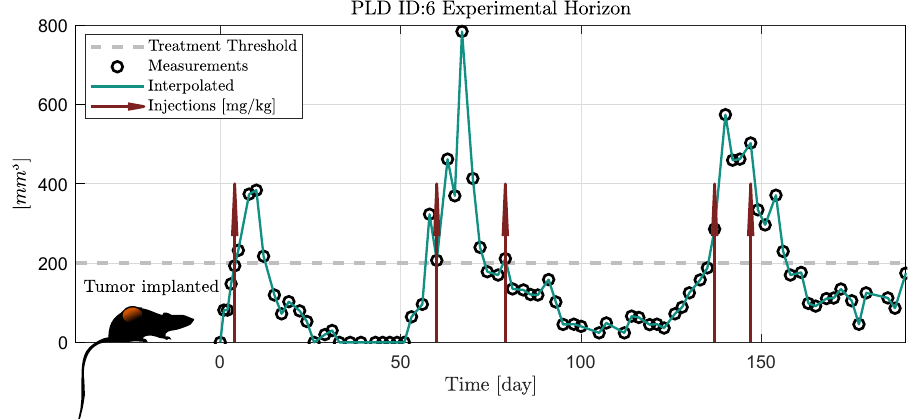
Figure 1. Scheme of the experiment from [14].